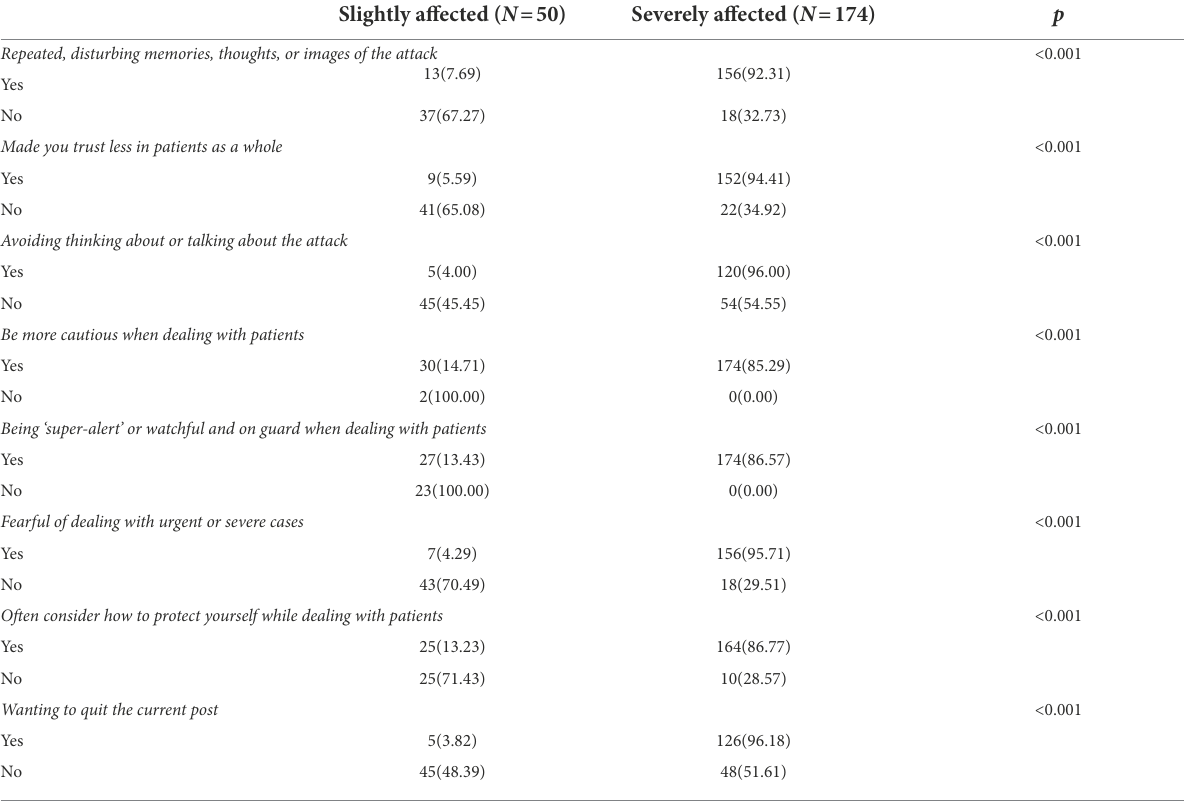
TABLE 2 Impacts of workplace violence on health workers stratified by group N (%). Slightly affected ( N =